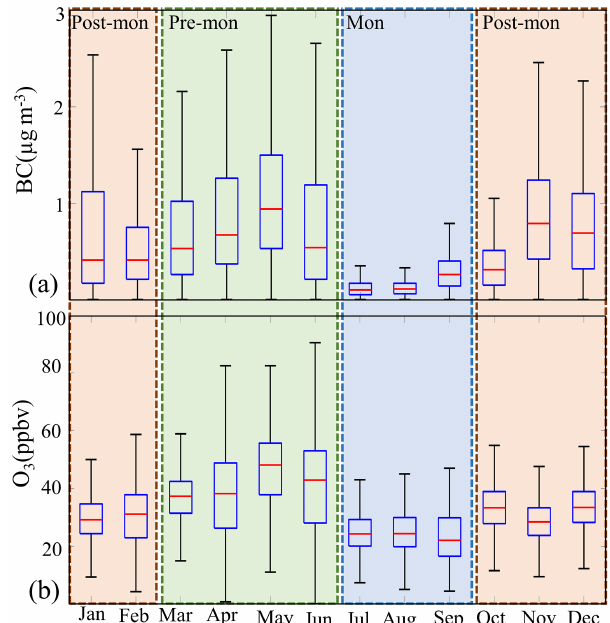
Figure 5. Box-and-whisker plots depicting the 90th, 75th, 50th, 25th, and 10th percentiles for monthly concentrations of BC (a) and O 3 (b) between January 2013 and August 2015 at JSM_STA. Or- ange shaded areas indicate the post-monsoon season (Post-mon), green shaded area indicates the pre-monsoon (Pre-mon), and blue are indicates the monsoon (Mon)